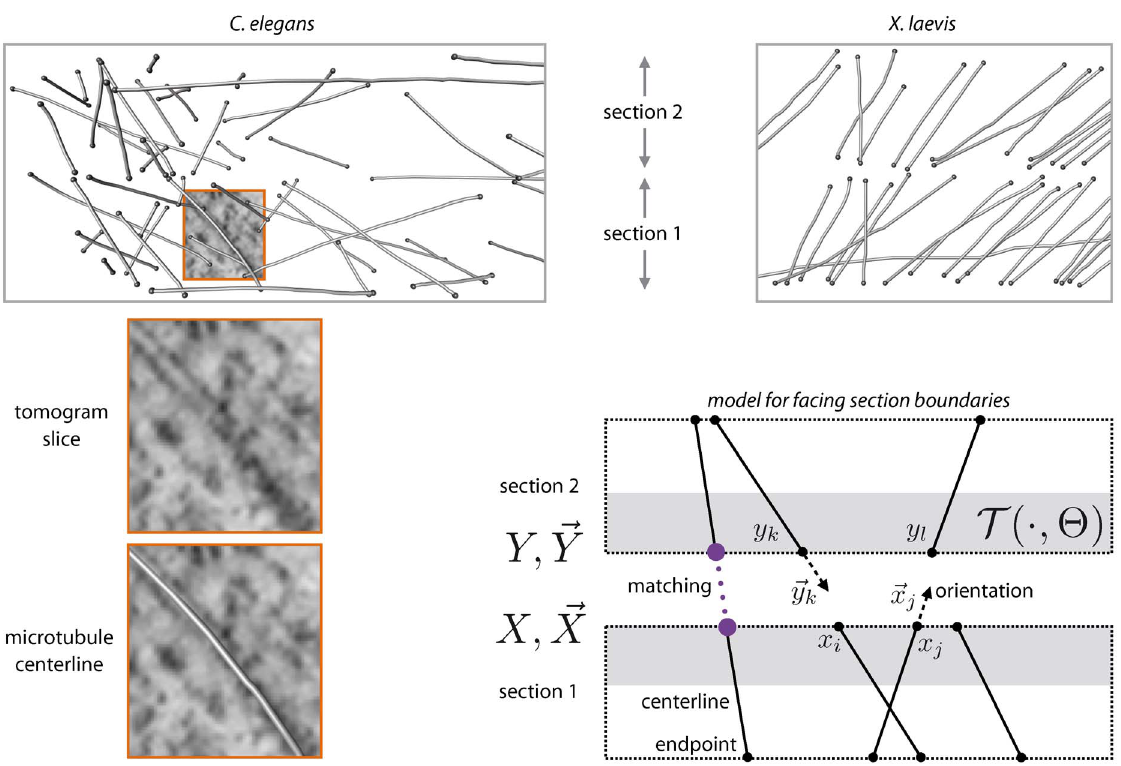
Figure 3. Model for section boundary. Top: View from side at traced microtubule centerlines for two small regions from two neighboring sections of a C. elegans sample and a X. laevis sample. For the purpose of illustration, the sections have been aligned. Many microtubules are regularly oriented in parallel bundles in the X. laevis sample. Microtubules are less regularly oriented in the C. elegans sample. Bottom left: Part of a centerline together with the corresponding tomogram slice. Bottom right: Model for boundary between two neighboring sections. Microtubule centerlines are modeled as straight lines with a single orientation (illustrated as dashed arrows). Endpoints close to a boundary (gray area) are described by two-dimensional coordinates as if they were located in a single plane. The transformation T acts on one section boundary (the y ’s in section 2). A matching consists of pairs of corresponding endpoints (one pair indicated as dotted line). The goal is to find a transformation and a matching such that corresponding centerlines can be connected across several sections. See main text for detailed notation.